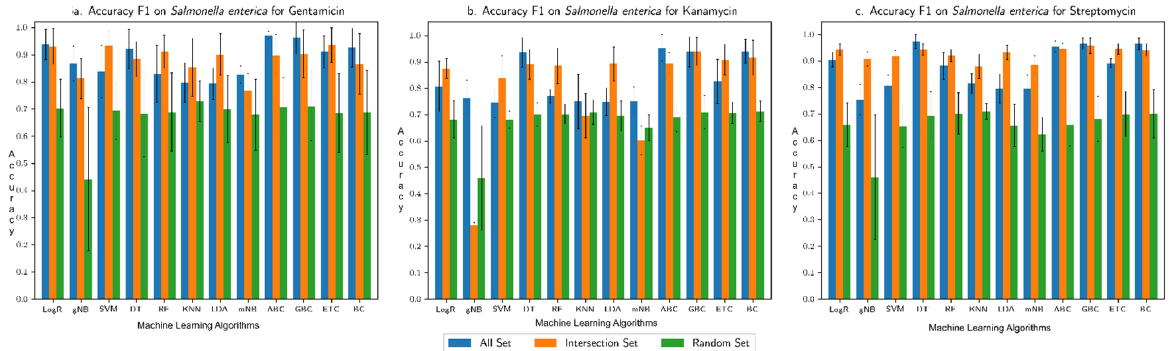
Figure 5. Overall accuracy (F1 score) produced by different machine learning algorithms in predicting resistance for S. enterica to ( a ) Gentamicin, ( b ) Kanamycin, and ( c ) Streptomycin. “All Set” denotes all genes of a genome of interest, “Intersection Set” contains genes that consistently ranked high in their importance in discriminating resistant from susceptible strains in each round of cross-validation, and “Random Set” contains randomly sampled genes from All Set (same number of genes as in Intersection Set). Performance was assessed for each of three input datasets in a 6-fold cross-validation